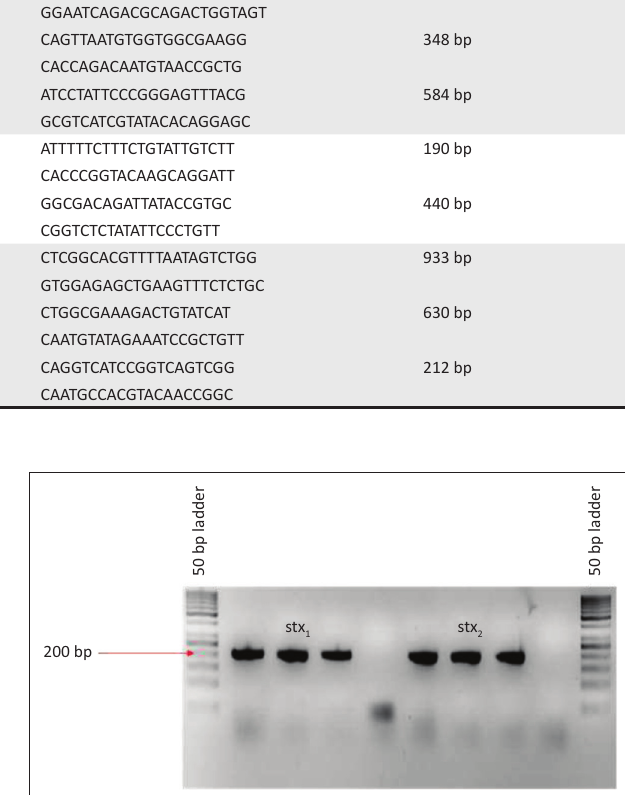
and stx after 1 2